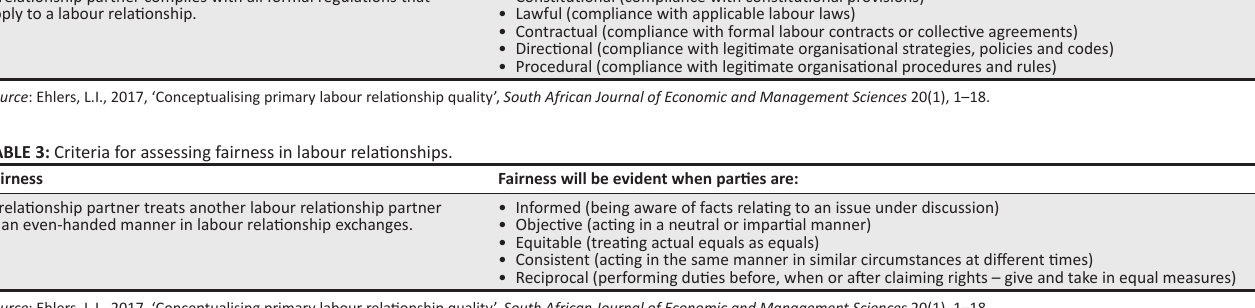
TABLE 2: Criteria for assessing compliance in labour relationships. Compliance